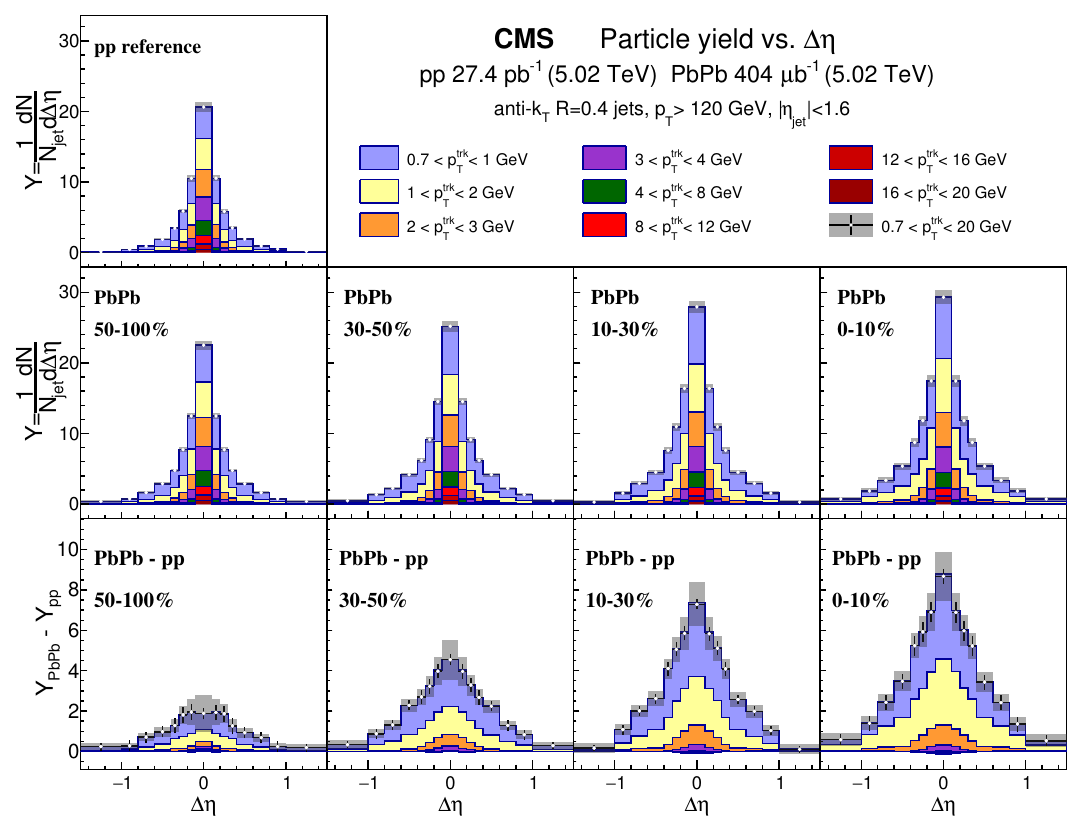
Figure 1 . The distribution of jet-correlated charged-particle tracks with j (cid:1) (cid:30) j < 1 : 0 as a function of (cid:1) (cid:17) in pp (top left) and PbPb (middle row) collisions. The PbPb results are shown for di(cid:11)erent centrality regions. The bottom row shows the di(cid:11)erence between the PbPb and pp data. The intervals in p trk are indicated by the stacked histograms. The inclusive points (0 : 7 < p trk T are shown by open white circles. The grey bands surrounding these points show the total systematic